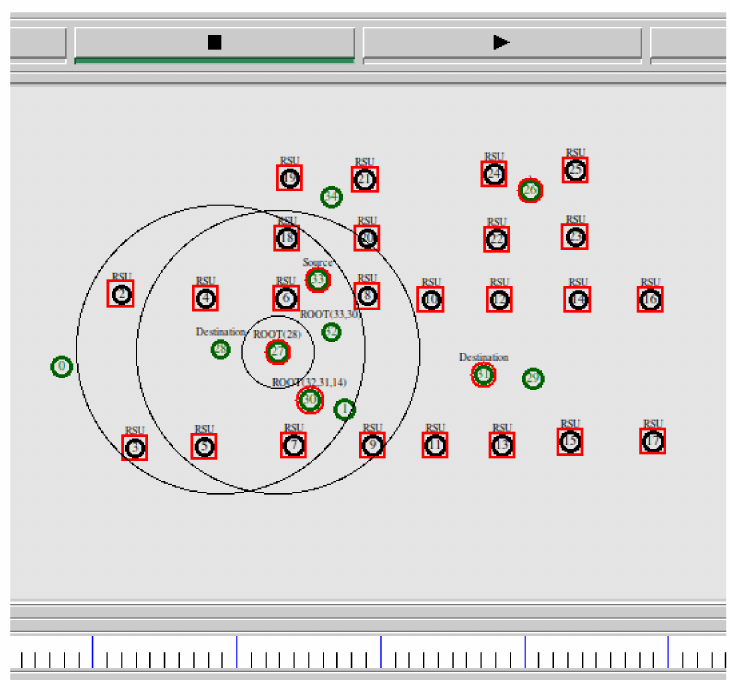
Figure 8. After multicasting, root node again sends a Route Reply Packet. Different performance metrics (parameters) are to be taken further in this research work such as delay analysis, fuel emission analysis, packet delivery ratio analysis, and throughput analysis of flying nodes. There is a comparison between two routing protocols such as GPMOR and Greedy Perimeter Stateless Routing